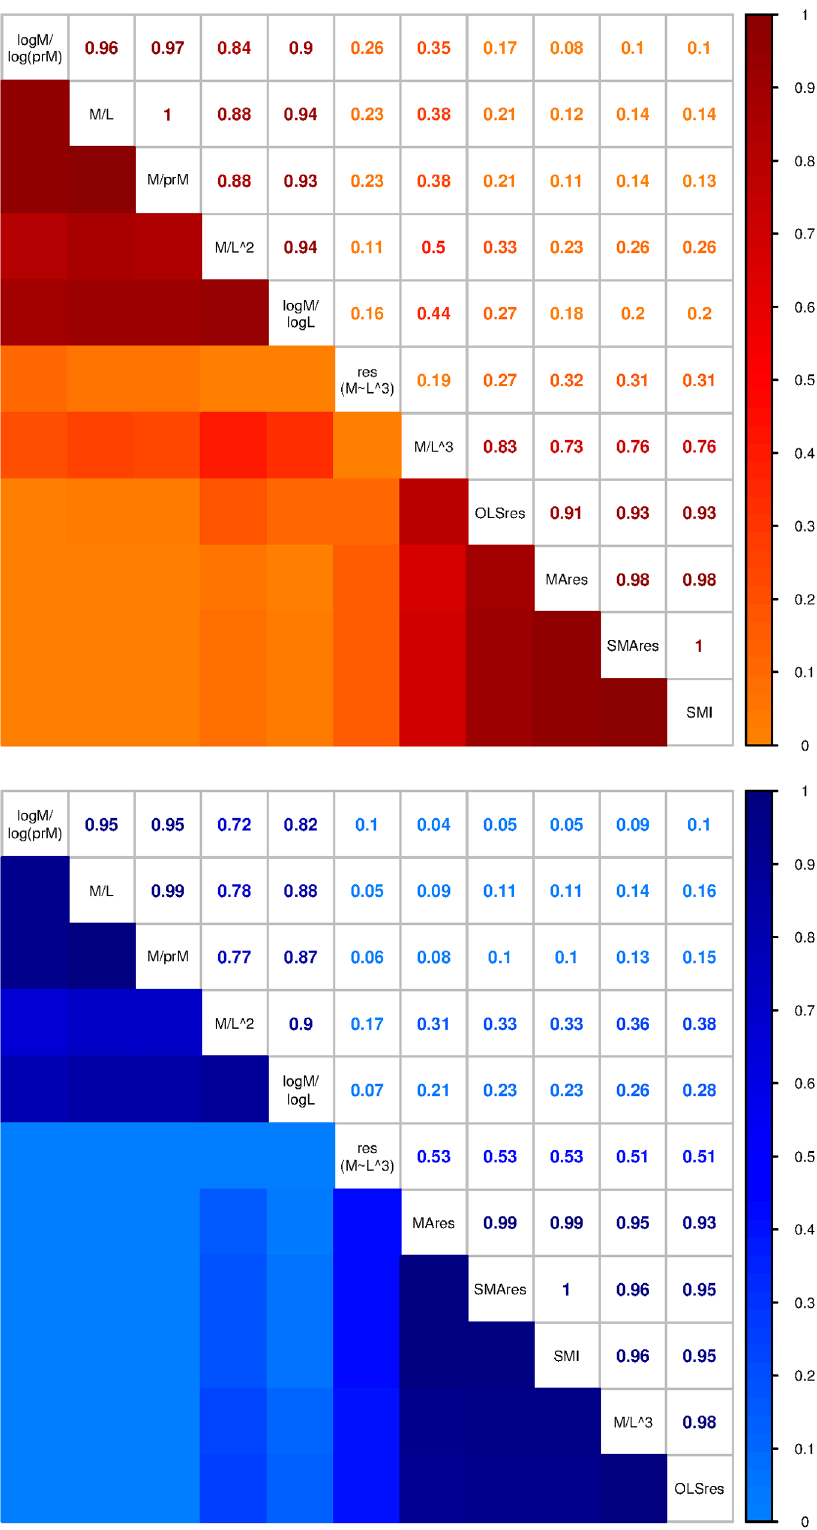
Fig 6. Correlations (Kendall’s τ ) among 11 body condition indices (BCIs) for each sex. Most BCIs fall into two groups, and certain BCIs are very similar to others (e.g., the MA residual index, the SMA residual index, and the SMI are all strongly correlatedto each other). Descriptionsof each BCI are providedin Table 1. https://doi.org/10.1371/journal.pone.0180791.g006 PLOS ONE | https://doi.org/10.1371/journal.pone.0180791 July 19,